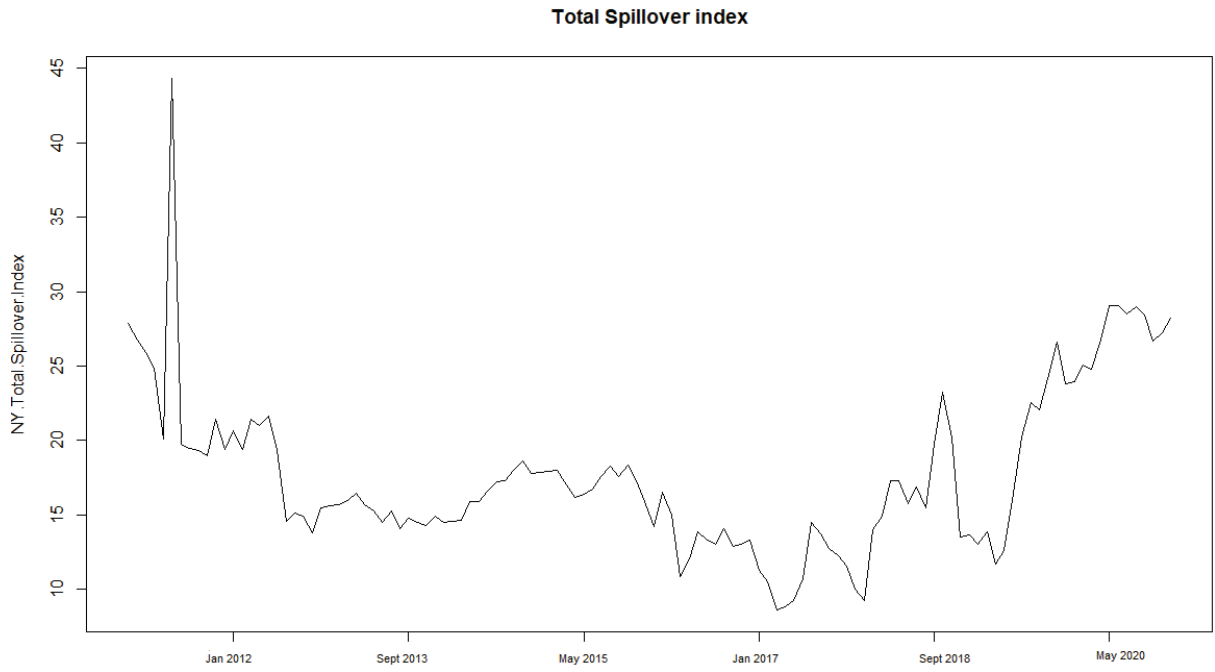
Figure 4. The Rolling Total Spillovers